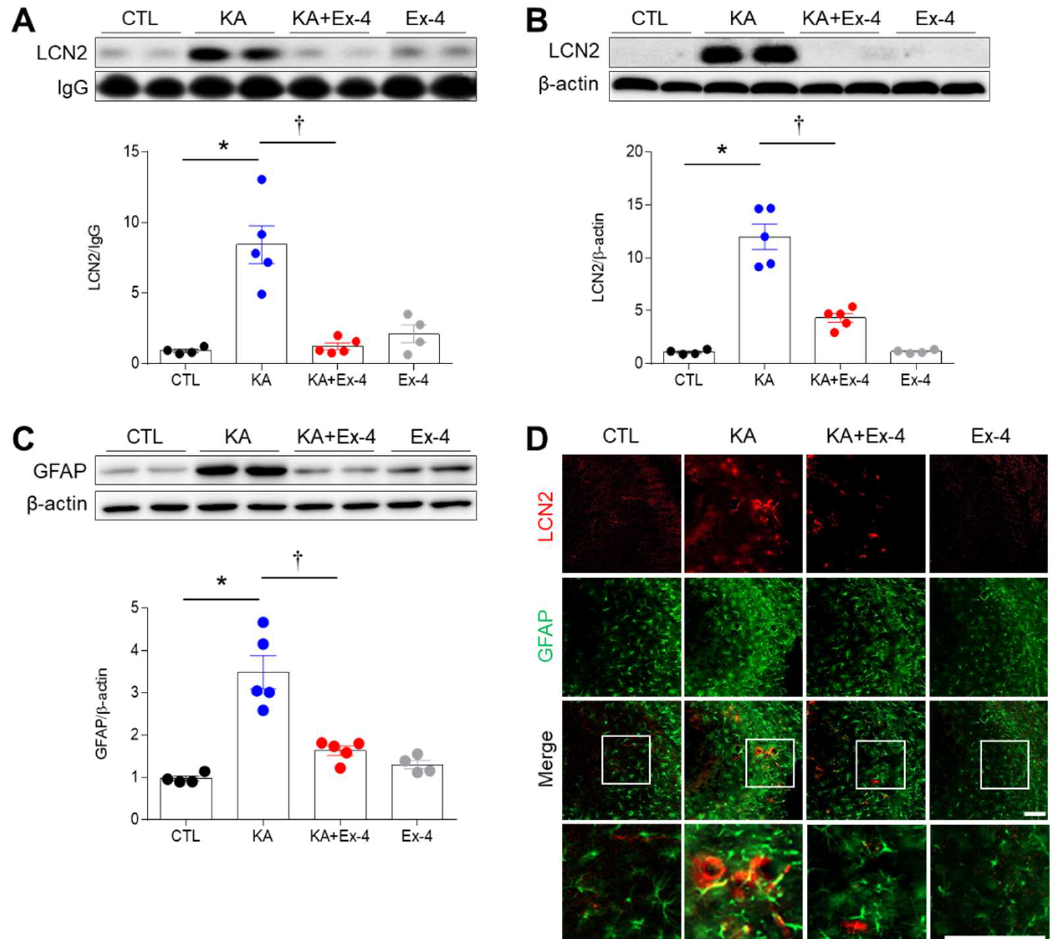
Figure 5. Effects of Ex-4 pretreatment on circulating and hippocampal LCN2 proteins in KA-treated mice. ( A ) Western blot showing circulation LCN2 levels. Ig G is used as an internal control to normalize protein levels ( n = 4–5 mice per group). ( B , C ) Western blot analysis of LCN2 ( B ) and GFAP ( C ) expressions in the mouse hippocampus. Densitometric values for LCN2 and GFAP were normalized to β -actin levels ( n = 4–5 mice per group). ( D ) Representative images of double immunofluorescence showing the co-localization of LCN2 and GFAP in the hippocampal CA3 region 24 h after KA treatment. The areas in white squares are magnified on the lowest panel. Scale bar = 50 µ m. Data are presented as mean ± SEM. * p < 0.05 vs. CTL, † p < 0.05 vs. KA. The one-way ANOVA was used to determine whether statistically significant differences between groups ( A – C ). LCN2/IgG; p values = 0.0001 (KA), 0.0001 (KA + Ex-4), F (3, 14) = 20.02, LCN2/ β –actin; p values = 0.0001 (KA), 0.0001 (KA + Ex-4), F (3, 14) = 53.09, GFAP/ β –actin; p values = 0.0001 (KA), 0.0002 (KA + Ex-4), F (3, 14) =